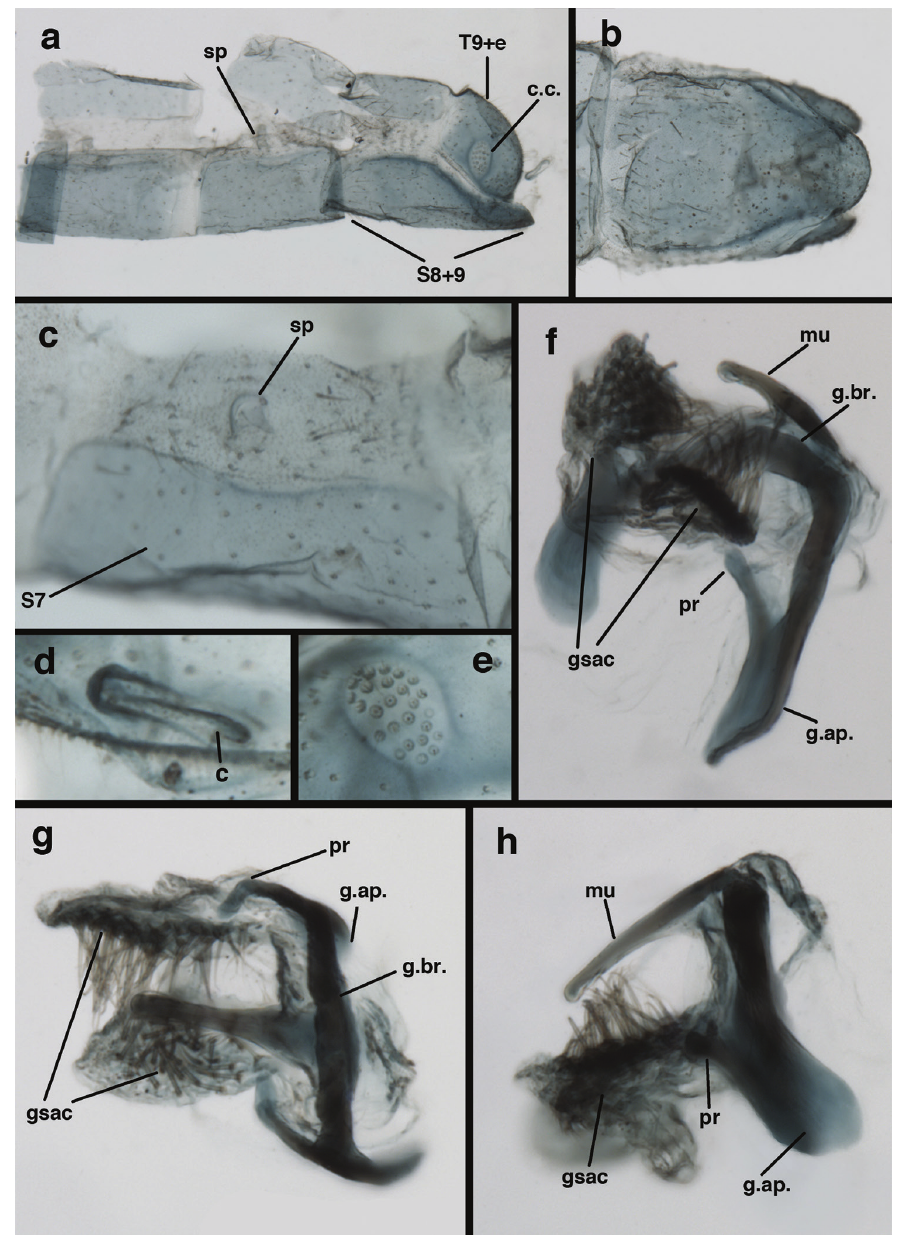
Figure 123. Chrysopa scalai Navás: Male abdomen and genitalia, ( a ) segments A6-terminus, lateral ( b ) fused sternites 8+9, ventral ( c ) segment A7, lateral ( d ) hypandrium internum ( e ) callus cerci ( f ) gonarcal complex, frontolateral ( g ) gonarcal complex, dorsal ( h ) gonarcal complex, lateral. c comes c.c. callus cerci gsac gonosaccus g.ap. gonarcal apodeme g.br. gonarcal bridge mu mediuncus pr unarticulated process on frontal margin of gonarcal apodeme sp spiracle S7 seventh sternite S8+9 fused eighth and ninth sternites T9+e ninth tergite + ectoproct (Argentina, Rio Negro, lectotype,